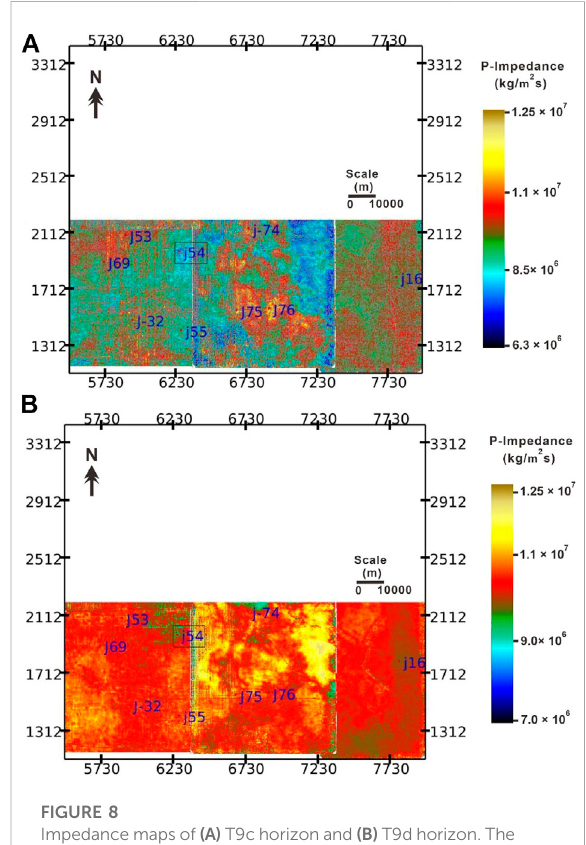
FIGURE 8 Impedance maps of (A) T9c horizon and (B) T9d horizon. The highlighted well J54 is utilized in the study to assess the vertical distribution of